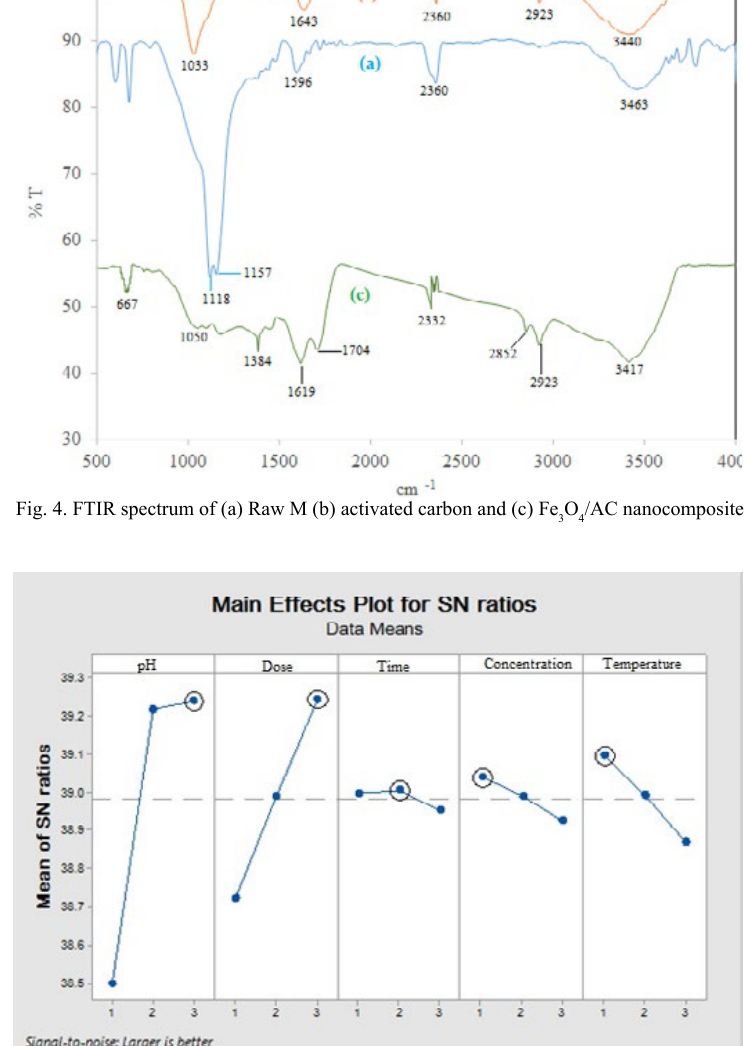
Fig. 5. The variation of S/N ratio of different